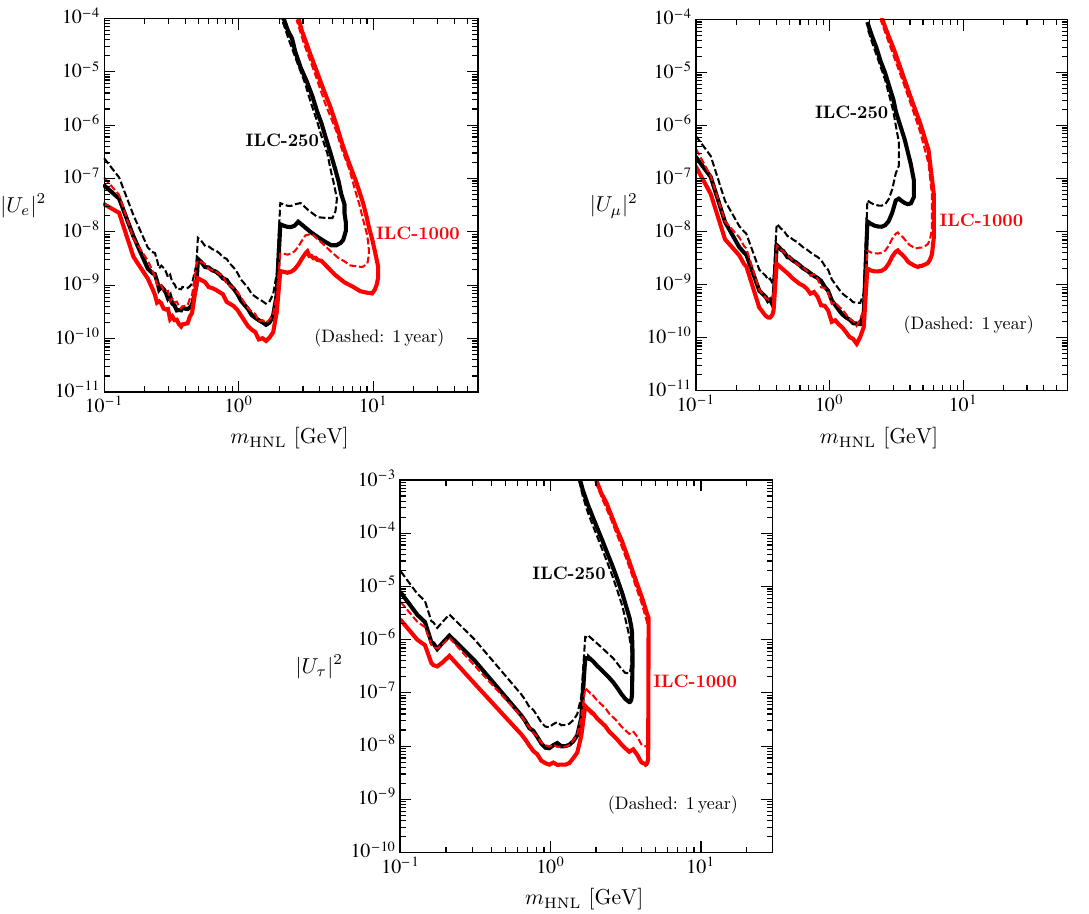
Figure 24 . Sensitivity plots for 1-year (dashed) and 10-year (solid) operations when U e , U µ , and U τ are